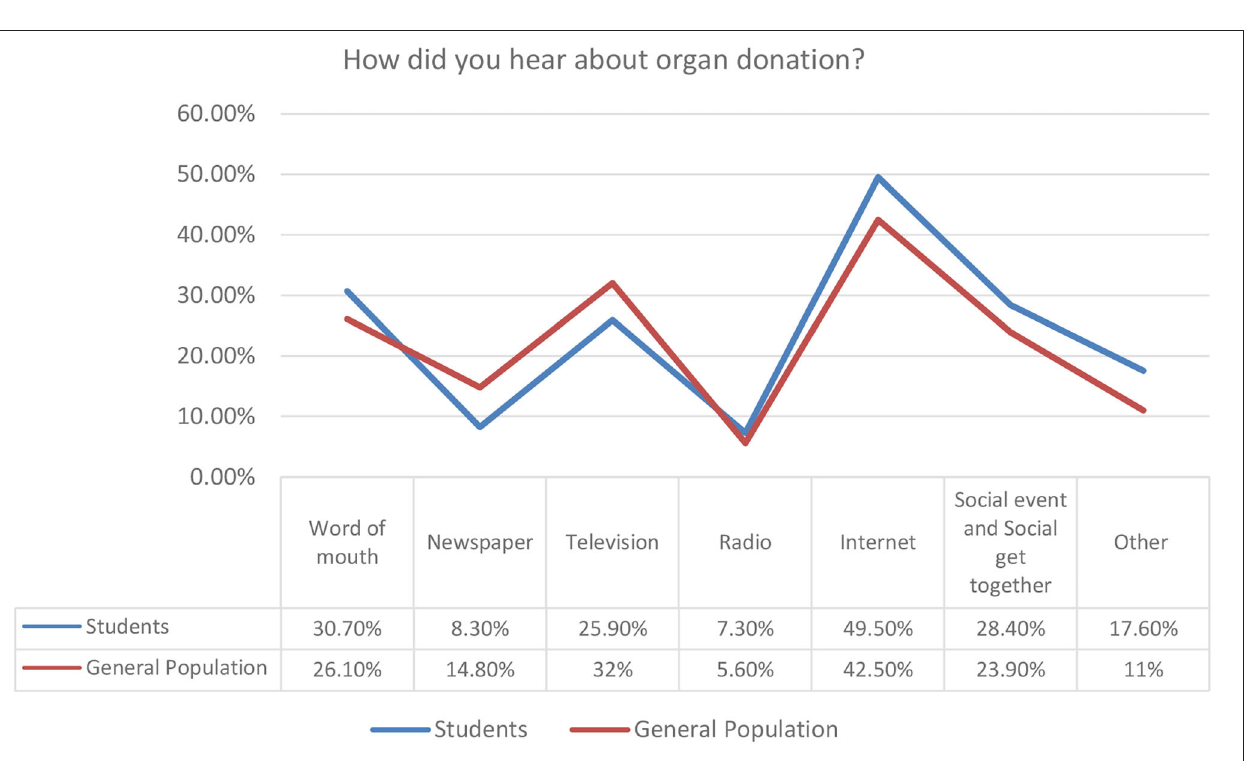
FIGURE 8 | Sources of awareness for organ donation campaign.